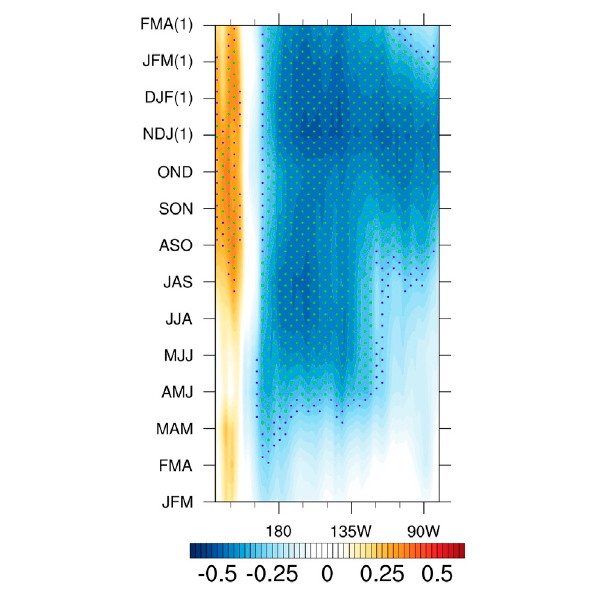
FIGURE 2 | Evolution of equatorial (5 ° S – 5 ° N-averaged) SST anomalies (Unit: ° C) obtained by correlation on the normalized JFM SHI index. Stippled regions in green (purple) indicate anomalies signi fi cant at the 90% (95%) con fi dence level according to the Student ’ s t test.